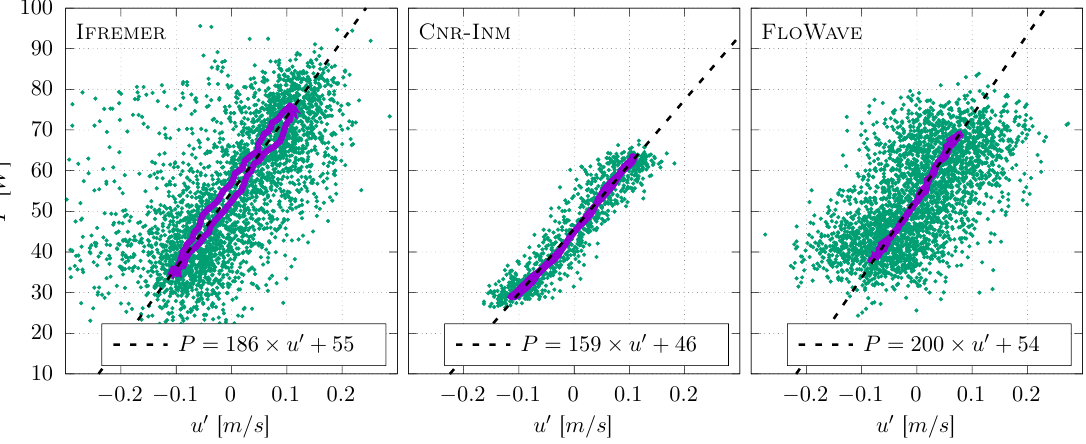
Figure 20. Power production of the turbine P versus the stream-wise fluctuation of the velocity u (cid:48) measured by the ADV on the side of the turbine (cf. Figure 6), for the wave and current case 2 at TSR = 4. Green points stand for the raw data, violet curve is the wave phase average of the power versus the wave phase average of the fluctuating velocity and dashed line stands for its best linear